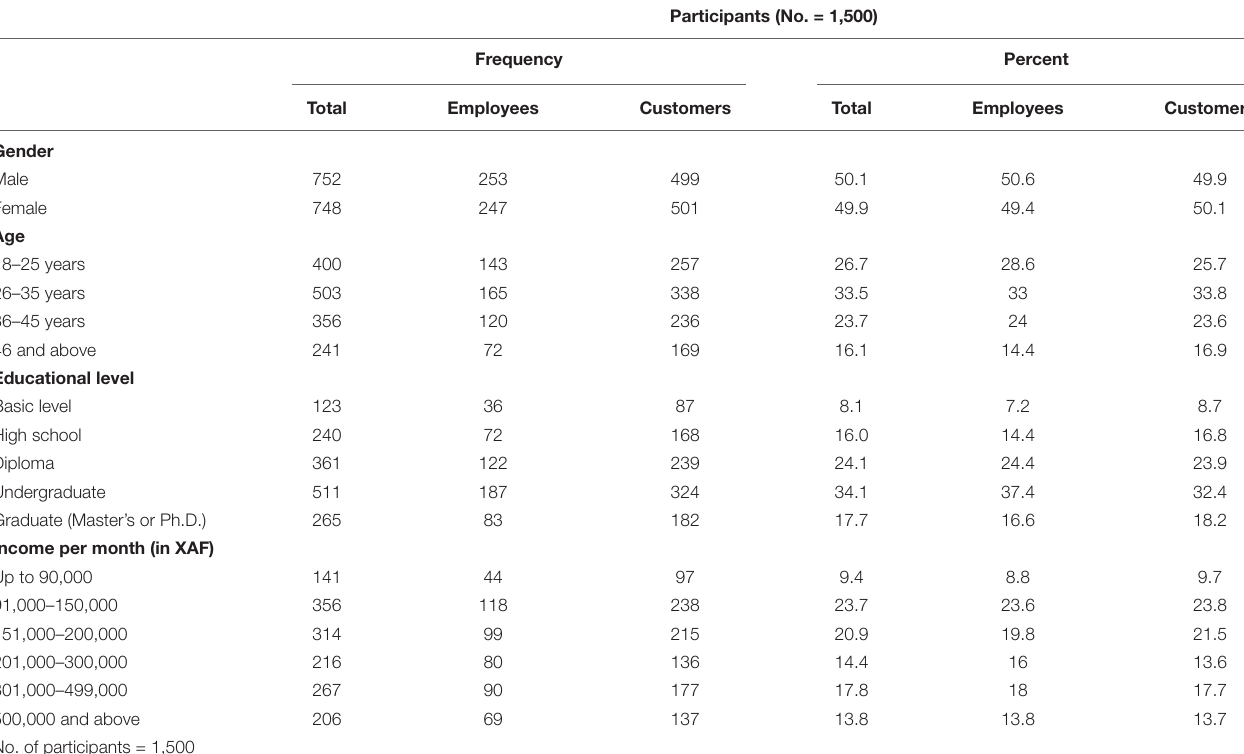
TABLE 4 | Demographics of